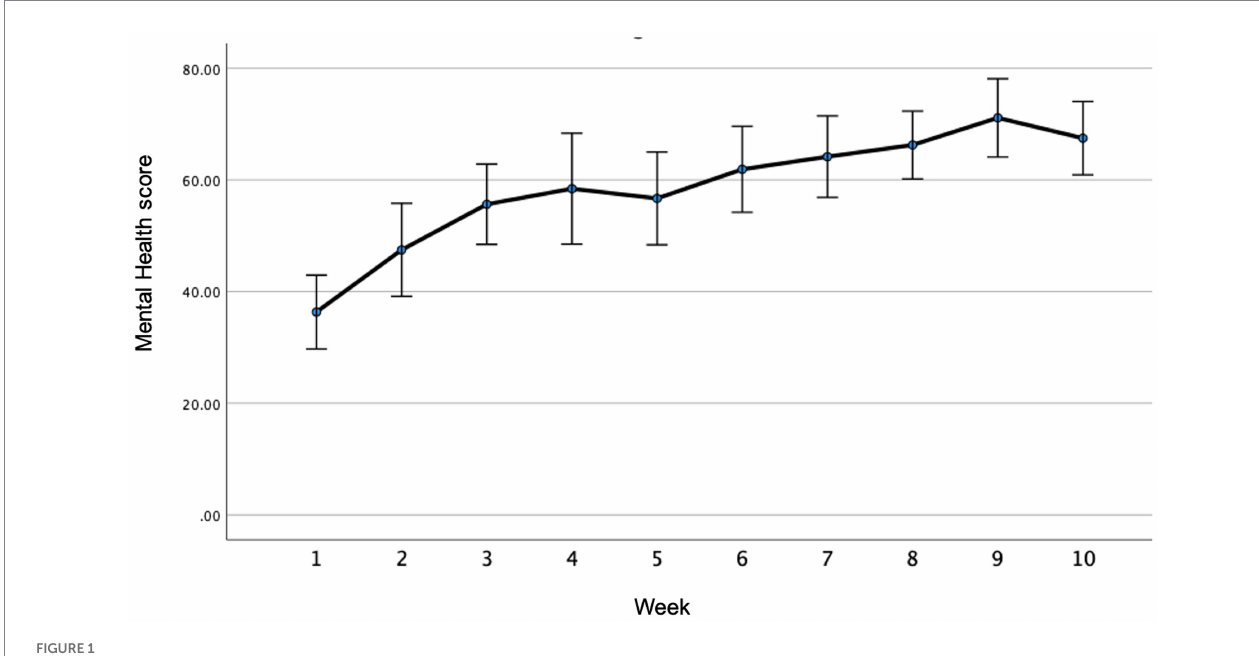
FIGURE 1 Weekly mental health (MH) scores throughtout the intervention.